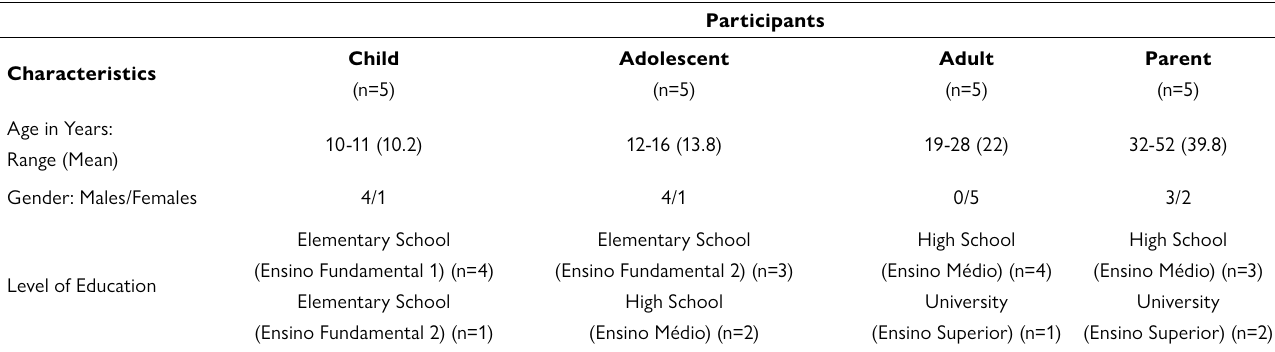
Table 2. Demographic characteristics of the cognitive interview participants